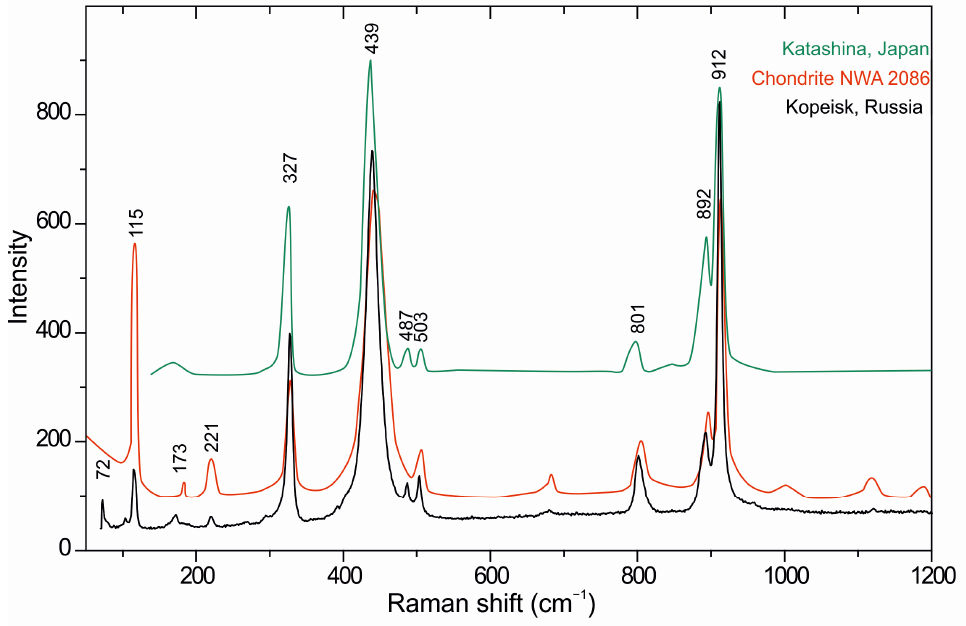
Figure 2. Raman spectrum of dmisteinbergite from Kopeisk (black) compared to the spectra obtained from the samples from Katashina village, Gunma Prefecture, Japan (green), and meteorite NWA 2086 (red).